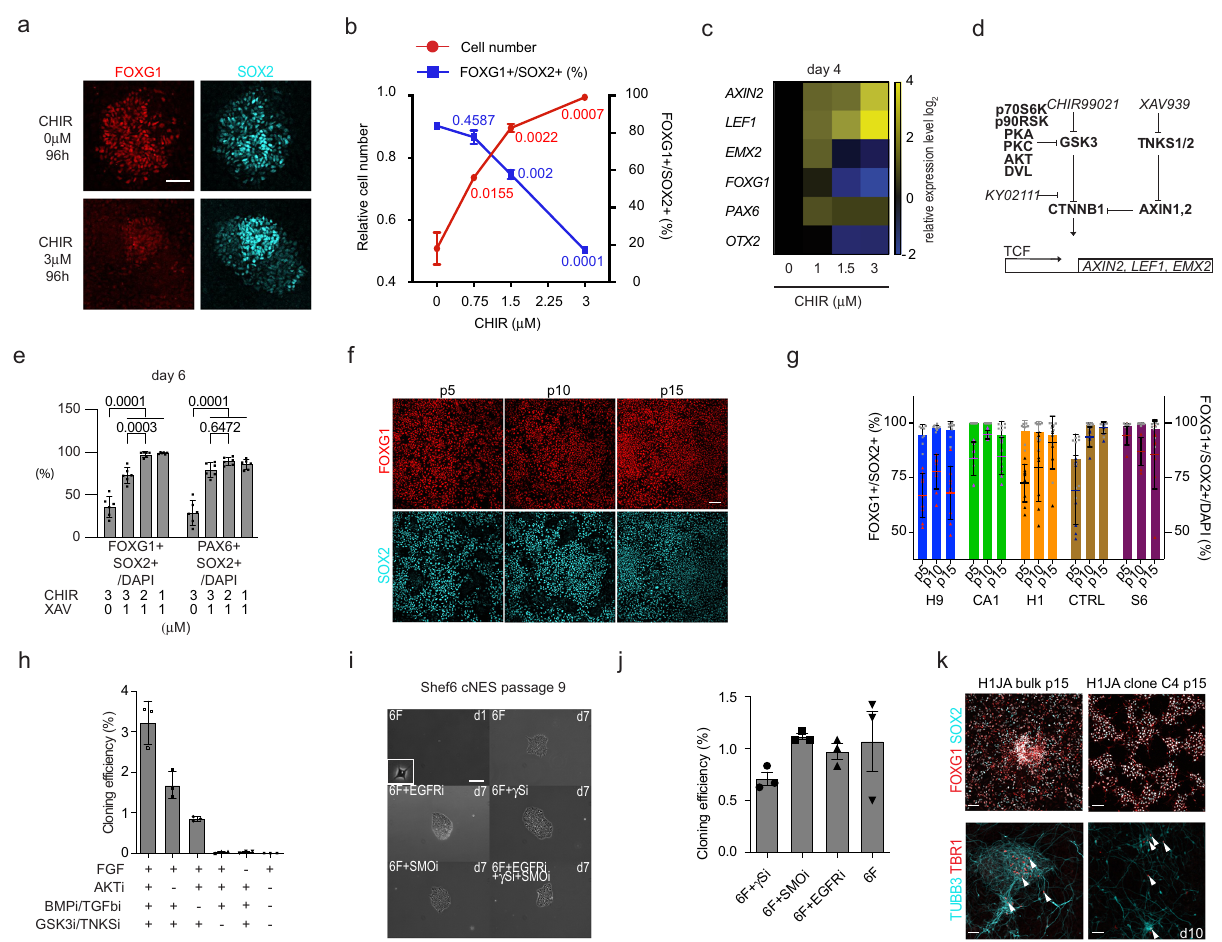
Fig. 3 Low CTNNB1 activity maintains cortical speci fi cation of cNESCs. a GSK3 inhibition reduces FOXG1 expression in SOX2 positive NES cells. The experiment was repeated with 3 biologically independent cell lines. Scalebar: 25 μ m. b GSK3 inhibition increases cNESC numbers and decreases FOXG1 positive cell number ratio over a 96-h treatment in the presence of FGF with TGFbR and BMPR inhibition. ( n = 3 independent experiments, data are presented as mean ± SD, 1-way ANOVA, Tukey ’ s test, p values are indicated for each comparison to 0 μ M CHIR). c Q-RT-PCR comparison of mRNA levels of selected dorsal forebrain speci fi c genes and direct CTNNB1 target genes AXIN2 and LEF1 after 96 h treatment of H1 cNESCs with various concentrations of GSK3 inhibitor (CHIR) in 4F media, normalised to 0 μ M treatment. (n = 3 biologically independent experiments, data are presented as mean). d Schematic of protein and chemical regulators of GSK3 and CTNNB1. Proteins are in bold, chemicals are in italic. e Quanti fi cation of FOXG1 and PAX6 positive SOX2 postive H1 cNESCs after 6 days culture in 4F media with various concentrations ( μ M) of GSK3 inhibitor (CHIR) and Tankyrase inhibitor XAV939 (XAV). ( n = 6 independent samples, data are presented as mean ± SD, 2-way ANOVA, Tukey ’ s test). f Immuno fl uorescent labelling of FOXG1 in H1JA cNESCs cultured in 6F condition from multiple passages. Scalebar: 25 μ m. g Quanti fi cation of immuno fl uorescent labelling of FOXG1 in fi ve independent hPSC derived cNESC lines from multiple passages. Bars and grey symbols show percentage of FOXG1 positive NES cells, lines and coloured symbols show percentage of FOXG1 and SOX2 positive cells of all cells. (n = 5 biologically independent cell lines, data are presented as mean ± SD). h Quanti fi cation of colony formation capacity of H1 cNESCs in 6F, 6F-AKTi, 6F-BMPi/TGFbi, 6F-GSK3i/TNKSi, 6F-FGF, FGF only. (n = 3 biologically independent experiments, data are presented as mean ± SD). i CNESCs (S6) form colonies in 6F condition in the presence of EGFR, SMO or γ S inhibitor or the combination of them. The experiment was repeated with 3 biologically independent samples. Scalebar: 50 μ m. j CNESCs (H1JA) were cultured in 6F media and plated at clonal density (200cells/cm2). Addition of NOTCH inhibitor DAPT, SMO inhibitor CYCK or EGFR inhibitor PD15 did not inhibit colony formation of cNESCs ( n = 3 biologically independent cell lines, data are presented as mean ± SEM). k Top: Single cell derived clones of cNESCs H1JA were cultured in 6F media. Dorsal forebrain marker FOXG1 was co-labelled with SOX2 neural marker by immuno fl uorescence in bulk cultures (left) and a clone of H1JA cNESCs (right, H1JA Clone C4). Bottom: H1JA and Clone C4 cNESCs could differentiate to TBR1 positive neurons (TUBB3) in ten days. Arrowheads indicate TBR1 and TUBB3 positive neurons. Scalebar: 20 μ m. The experiment was repeated with 5 biologically independent samples. Source data are provided as a Source Data fi le. differentiation, we observed spontaneous action potentials in voltage steps, we were able to detect both fast voltage-gated Na + currents and subsequent voltage-activated K + currents (Fig. 2k), around 50% of the cells (Fig. 2g). These cells could be further con fi rming the presence of necessary ion channel components for stimulated to fi re action potentials by applying ramp currents action potentials. Moreover, addition of glutamate receptor (Fig. 2h). When constant currents ( + 20 pA) were held for an agonist N -methyl-D-aspartic acid (NMDA, 1 mM) and conse- extended period (10 – 360 ms) (Fig. 2i) or increasing the current quent activation of postsynaptic receptors resulted in the steps from − 10 pA to + 40 pA up to 1000 ms (Fig. 2j), trains of induction of excitatory membrane currents (Fig. 2l). Together, action potentials were recorded. With increased depolarizing NATURE COMMUNICATIONS| (2022) 13:2844